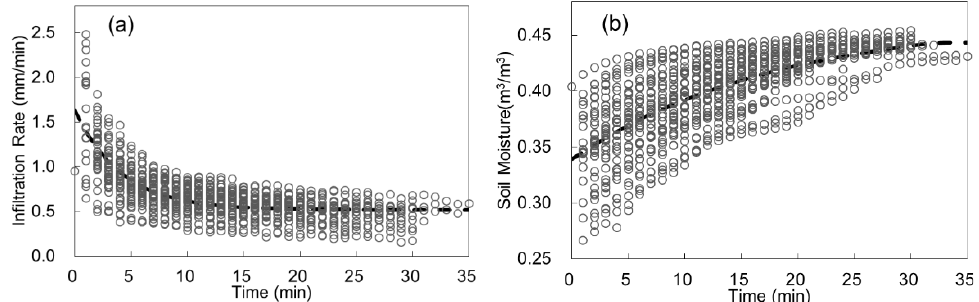
Figure 3. Change in infiltration rate and soil moisture with time: ( a ) change in the infiltration rate with time; ( b ) change in the soil moisture with time.